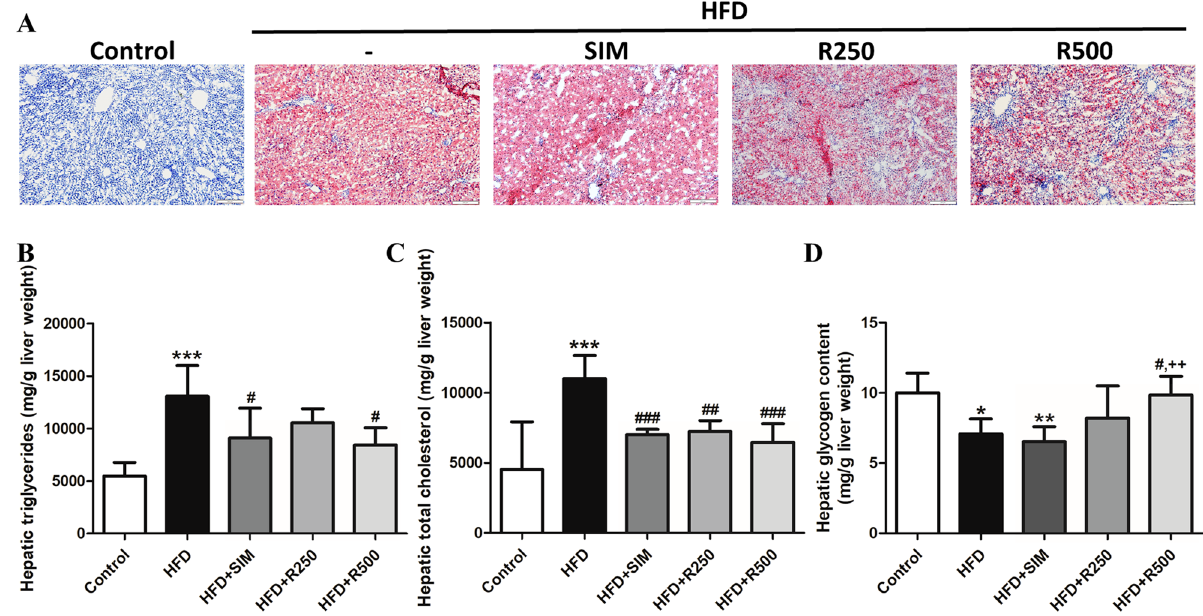
Figure 3. Effect of roselle extract on hepatic lipid accumulation in HFD-induced NAFLD. ( A ) Oil Red O staining (× 100), ( B ) hepatic triglycerides, ( C ) hepatic cholesterol, ( D ) hepatic glycogen content. Lipids and glycogen contents in the liver in rat fed with normal diet (control), high fat diet (HFD), high fat diet + simvastatin (HFD + SIM), high fat diet + 250 mg/kg BW of roselle extract (HFD + R250), and high fat diet + 500 mg/kg BW of roselle extract (HFD + R500). Data were represented as means ± SD from three replications (n = 5–7 per group). Statistical analysis was performed with one-way ANOVA followed by Tukey’s post hoc test. The mean differences were significant compared with the control group (* P < 0.05, ** P < 0.01, *** P < 0.001), HFD group ( # P < 0.05, ## P < 0.01, ### P < 0.001) and HFD + SIM group ( + P < 0.05, ++ P <